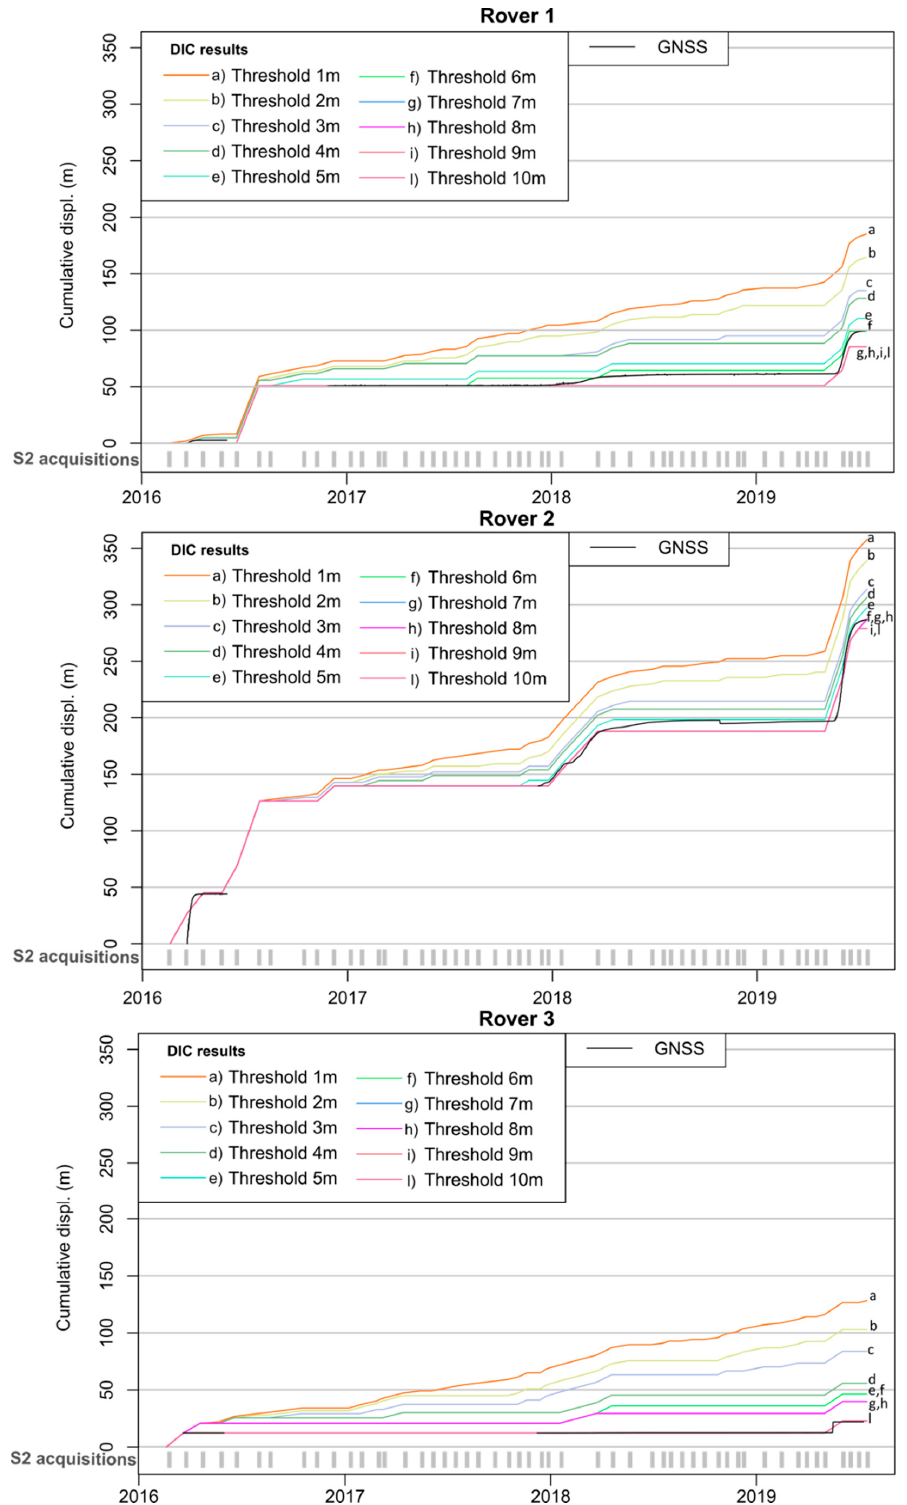
Figure 8. Comparison between cumulative planimetric DIC displ and GNSS displ . GNSS displ time-series of period “b” is translated on the y-axis in order to match the minimum DIC displ value recorded on the first date of the “b” period.